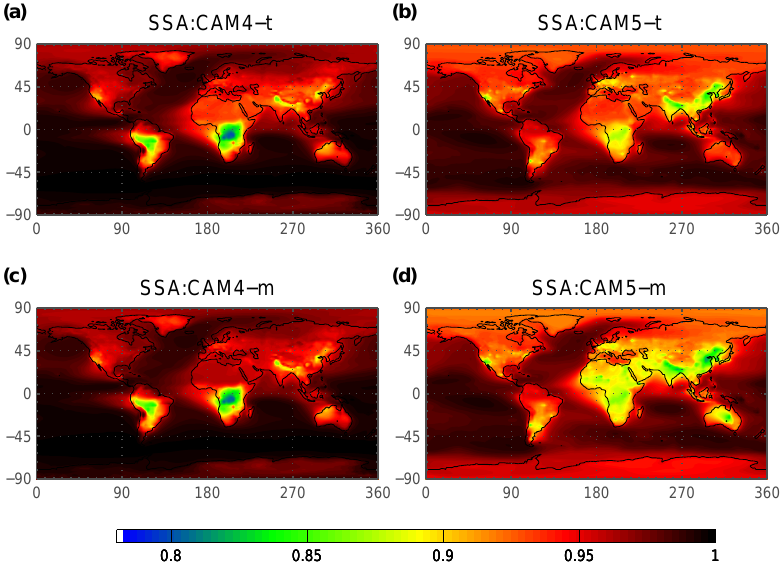
Figure 16. Model single scattering albedo for CAM4 with tuned dust (a) , CAM5 with tuned dust (b) , CAM4 with mineralogy (c) and CAM5 with mineralogy (d)